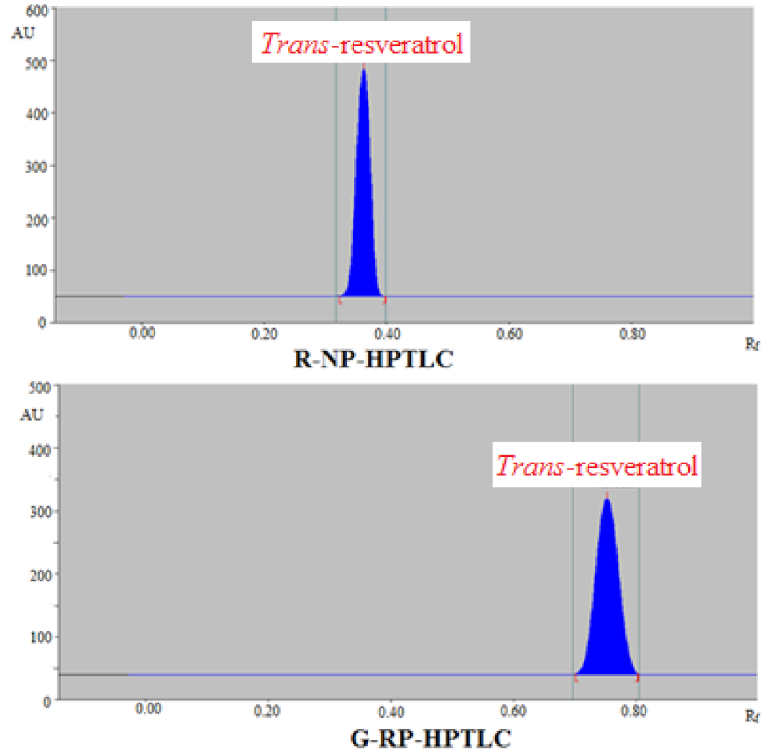
Figure 3. Representative densitometric chromatograms of TRV in marketed capsule dosage form obtained using R-NP-HPTLC and G-RP-HPTLC methods.